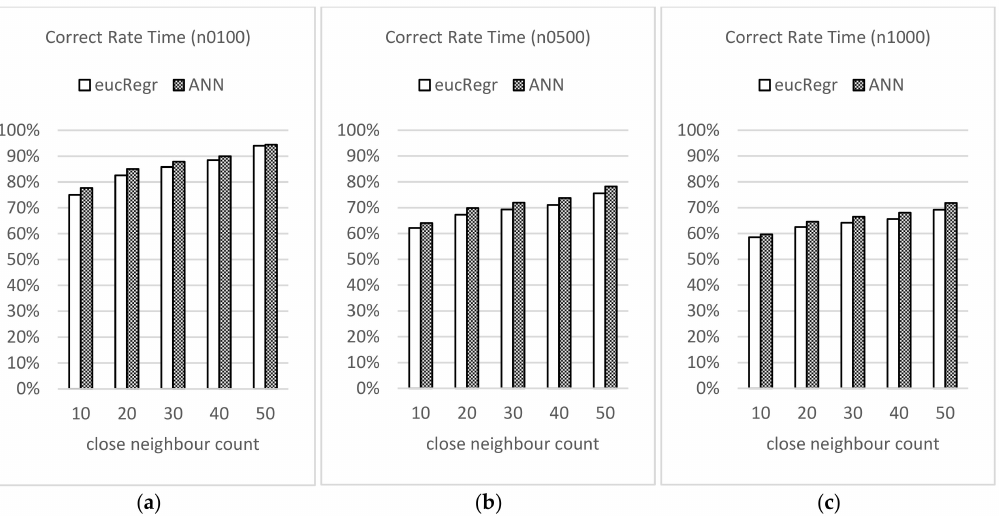
Figure 9. Correctness rate of selecting closest neighbors using estimated time. ( a ) Number of nodes = 100. ( b ) Number of nodes = 500. ( c ) Number of nodes =